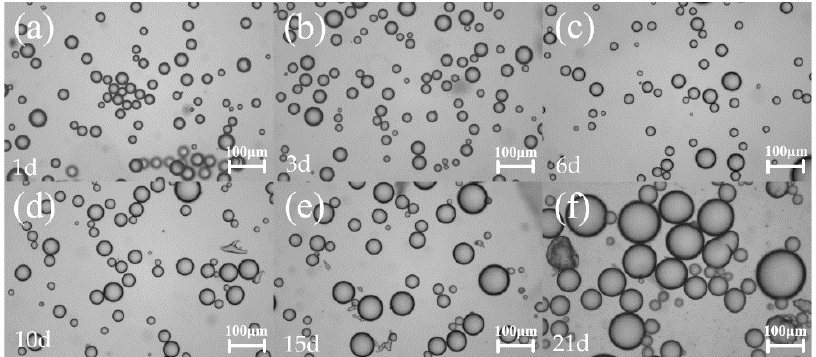
Figure 5. Microscopic images of Pickering emulsions with different droplet sizes at different storage times. The droplet sizes from ( a ) to ( f ) were 25.06 ± 6.27 μ m, 25.89 ± 7.30 μ m , 26.28 ± 7.02 μ m, 28.30 ±